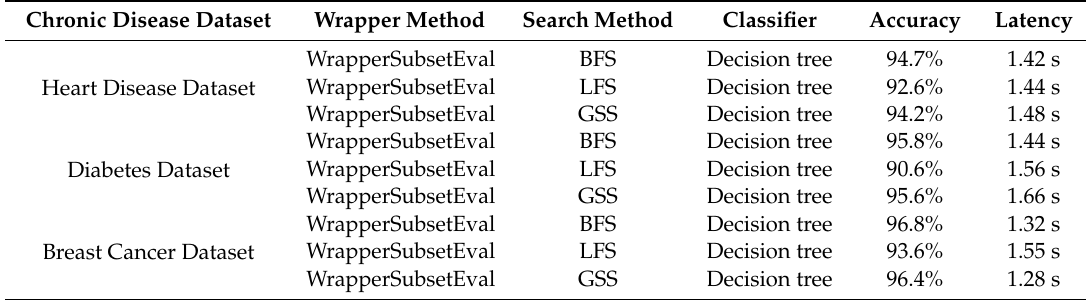
Table 11. An analysis of the classification accuracy and latency of the wrapper methods on disease datasets. Chronic Disease